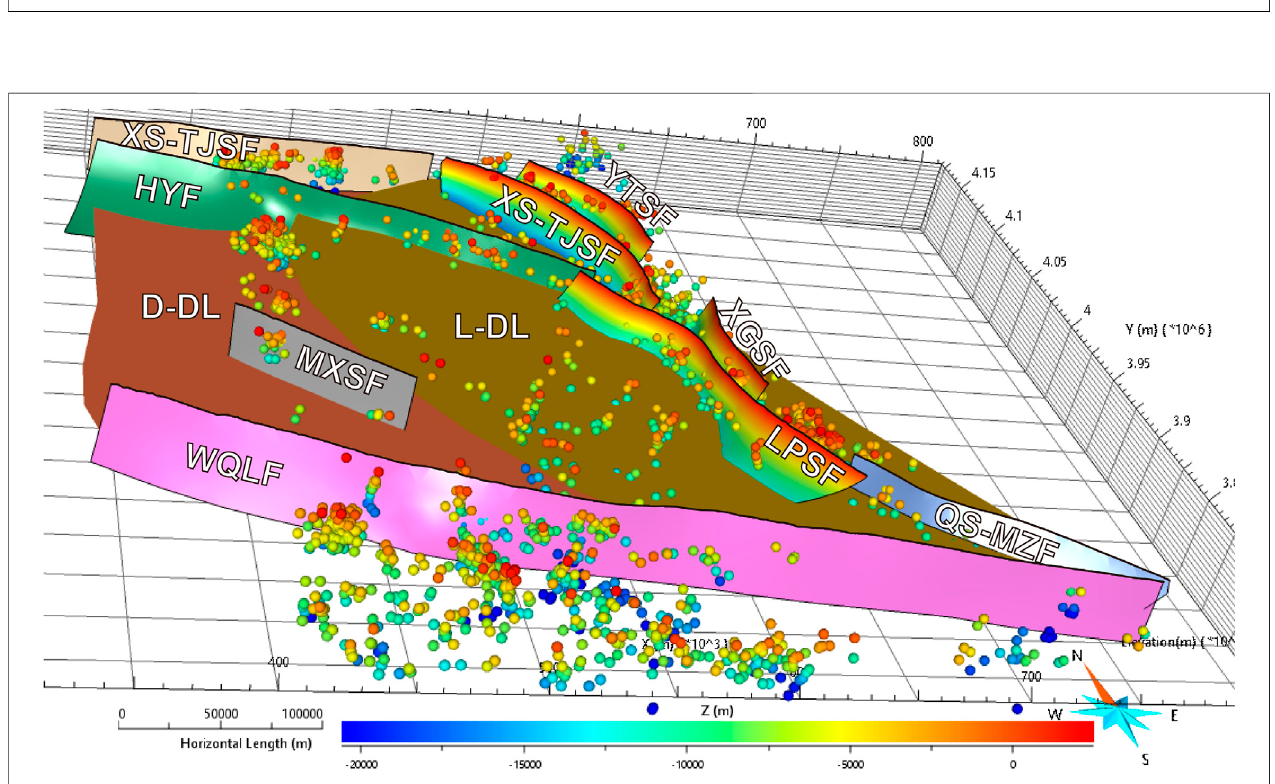
FIGURE 8 | Side view of 3D fault model V3 of the active faults in the arc-shaped tectonic belt in the northeastern margin of the Tibetan Plateau.